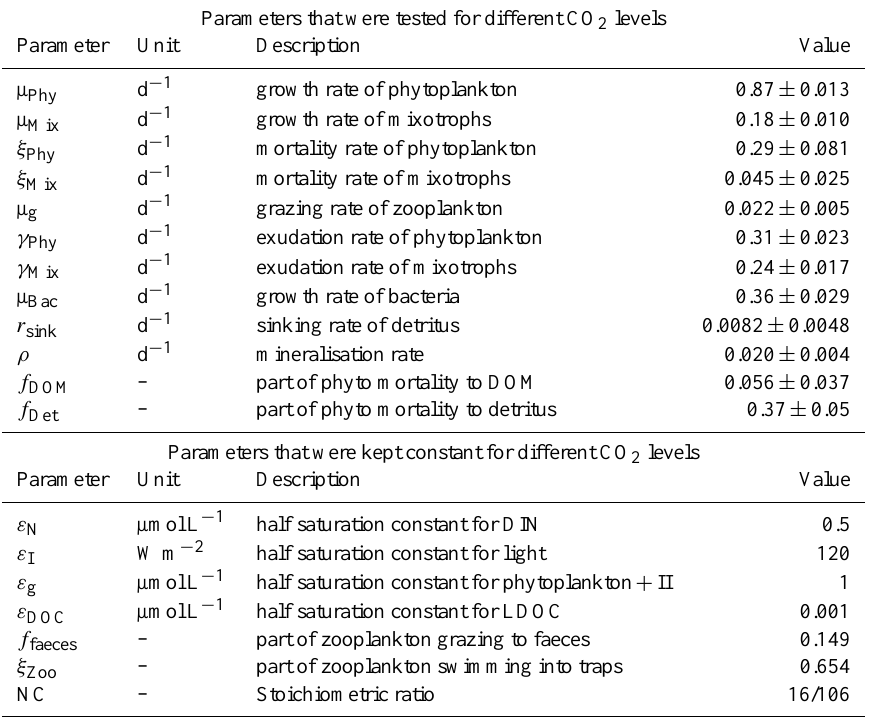
Table 2. Parameter descriptions and values of the food web model for phase 1 ( t 0 − 12 ) . Values are presented as average of all mesocosms ± standard deviation ( n = 9) derived from MCMC fitting